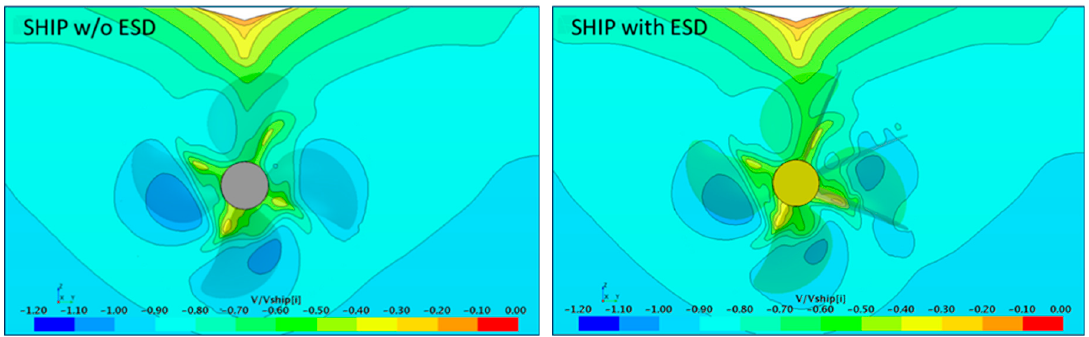
Figure 9. Distribution of the axial velocity on section “Sect 1” in front of the propeller, seen from upstream (PSS-Var-5, full scale, Vs = 14 kn).